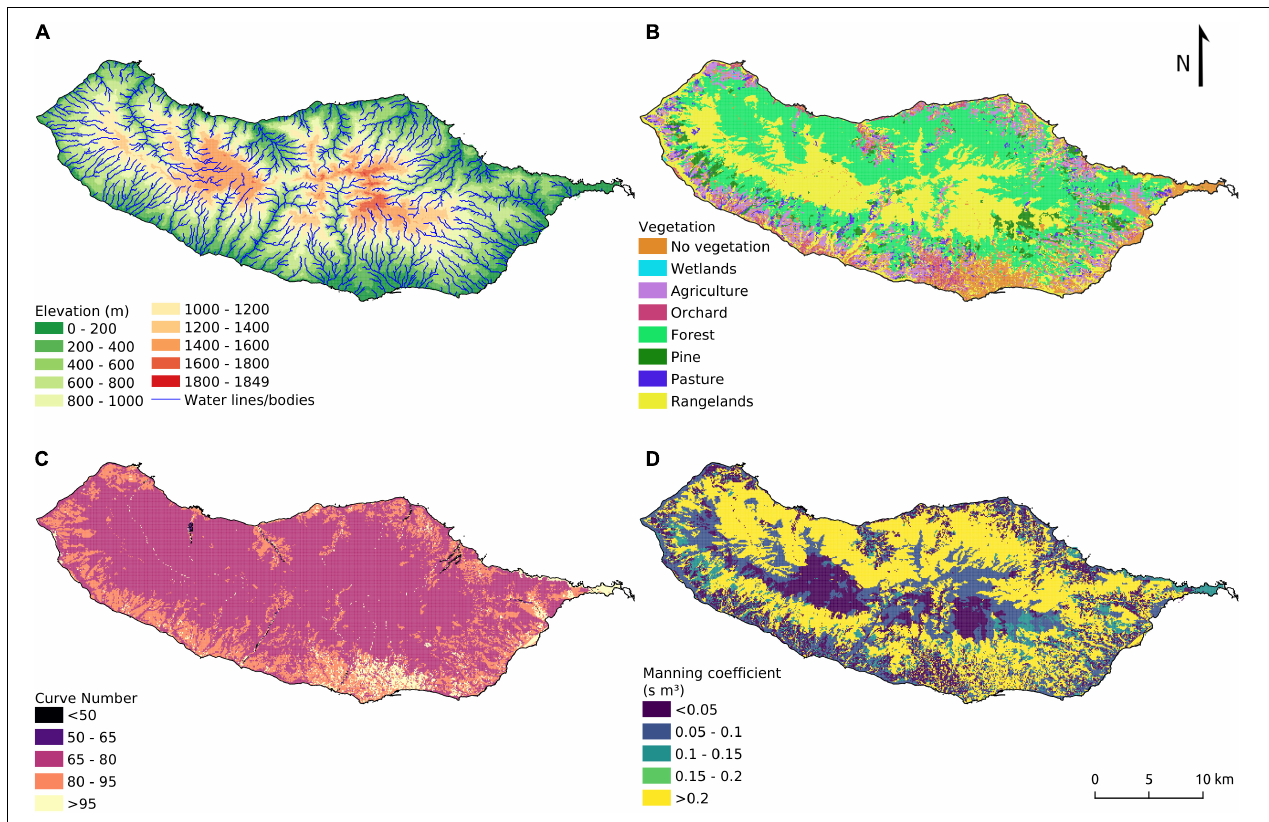
FIGURE 4 | Maps used in the hydrological simulations (MOHID-Land): (A) Digital Terrain Model with drainage network; (B) soil use; (C) curve number (CN-AMCII); (D) Manning coefficient.